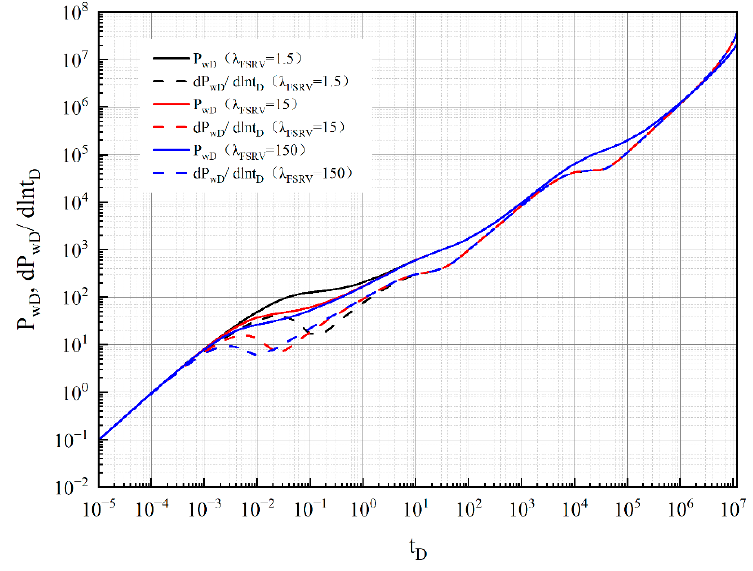
Figure 12. The effect of the FSRV inter-porosity flow coefficient on the pressure response.